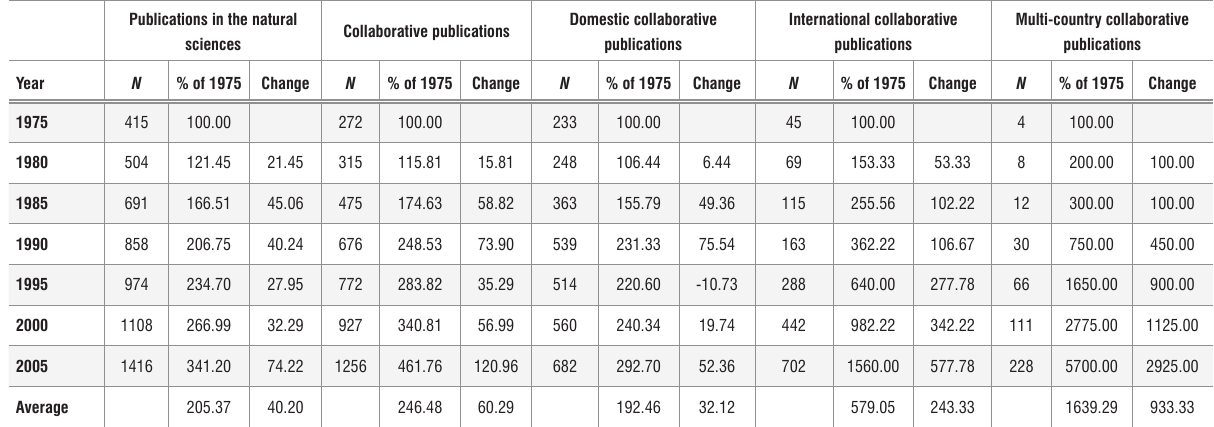
Correlation matrix of degree of collaboration in the natural sciences and other variables